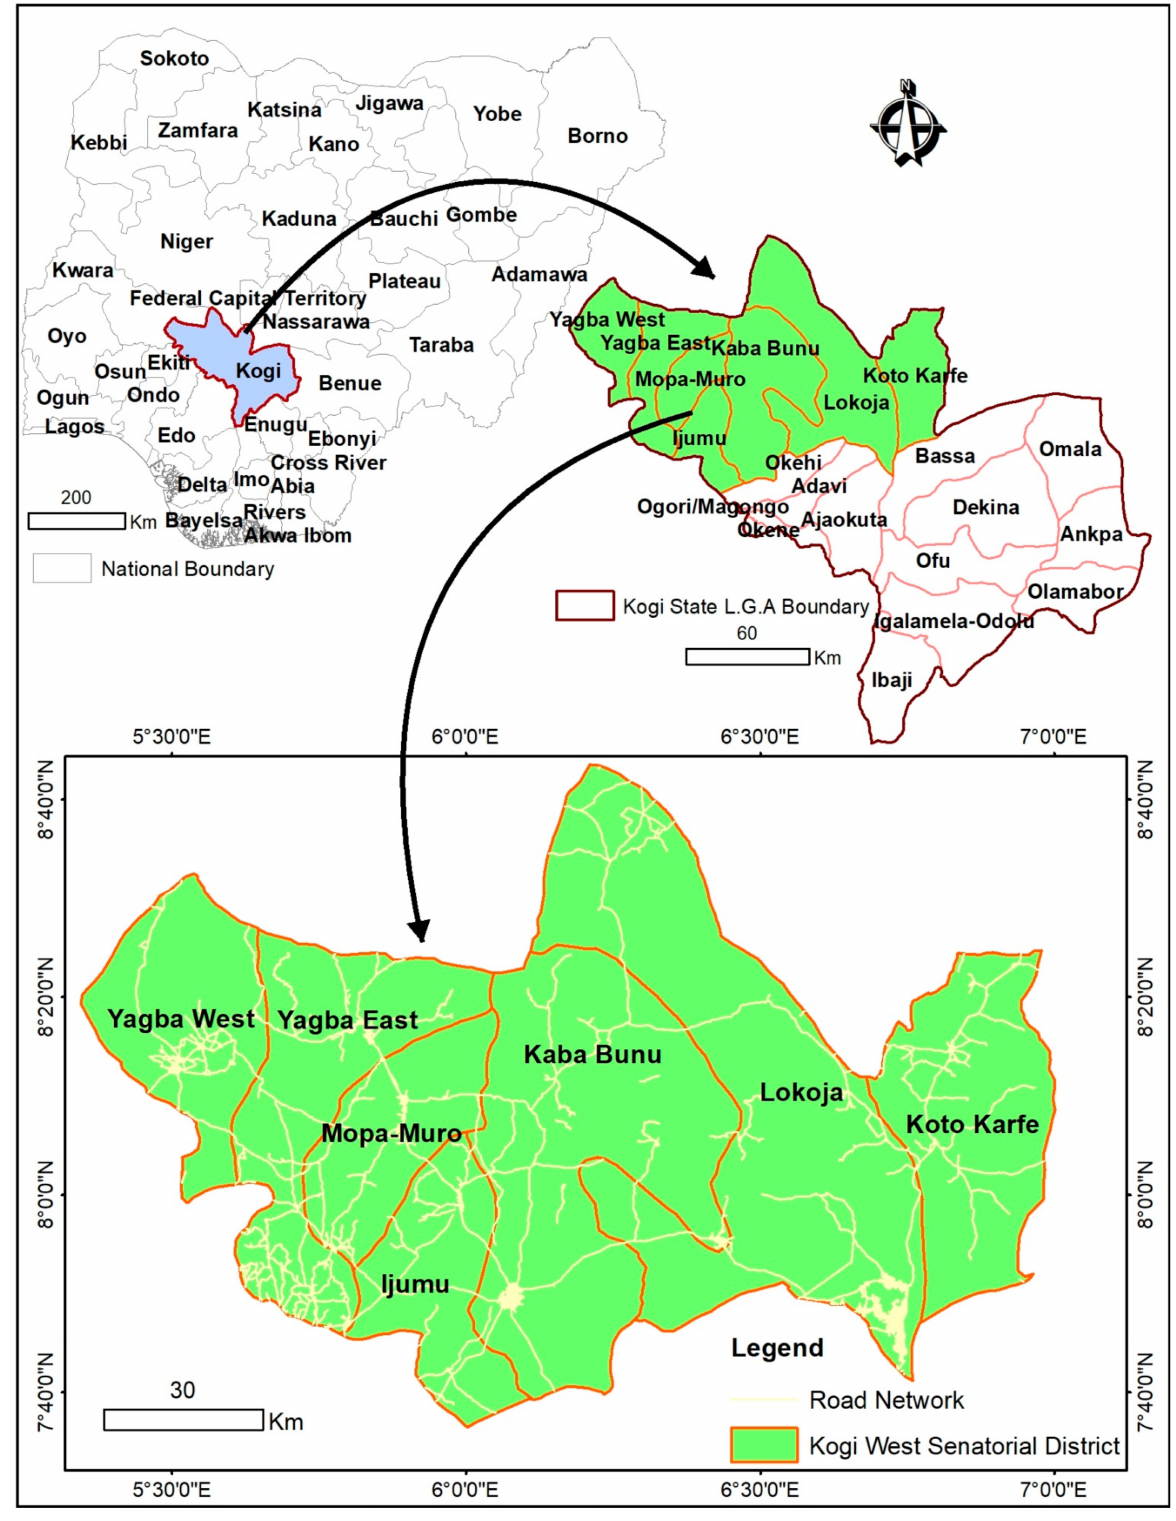
Figure 1. Geographical location of the selected communities in Kogi West Senatorial District of Kogi State, Nigeria. Source: